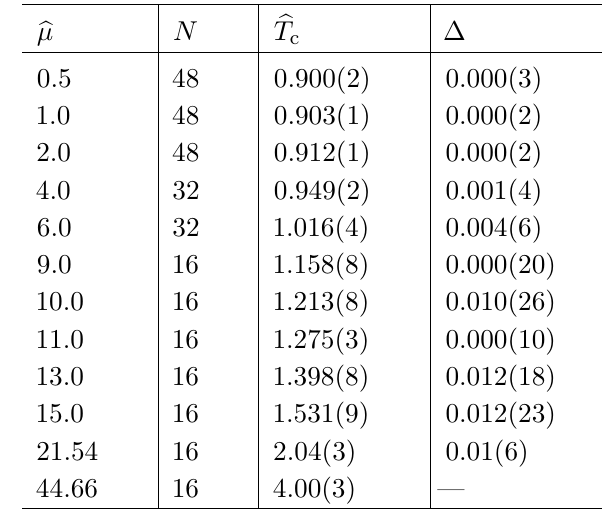
Table 1. The critical temperature b T c for the 12 larger N is needed. We determine b T the separatrix method. The last column shows the values of the ∆ parameter defined by eq.